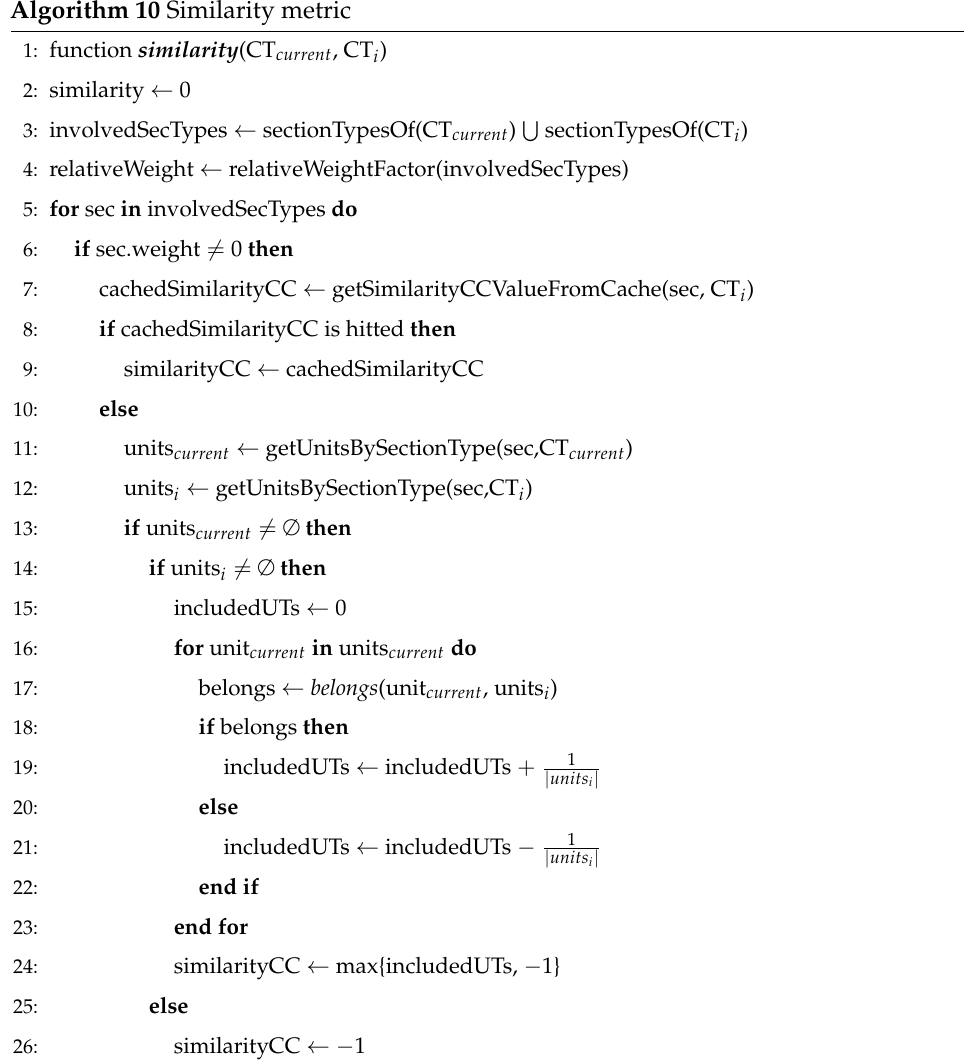
Algorithm 10 Similarity